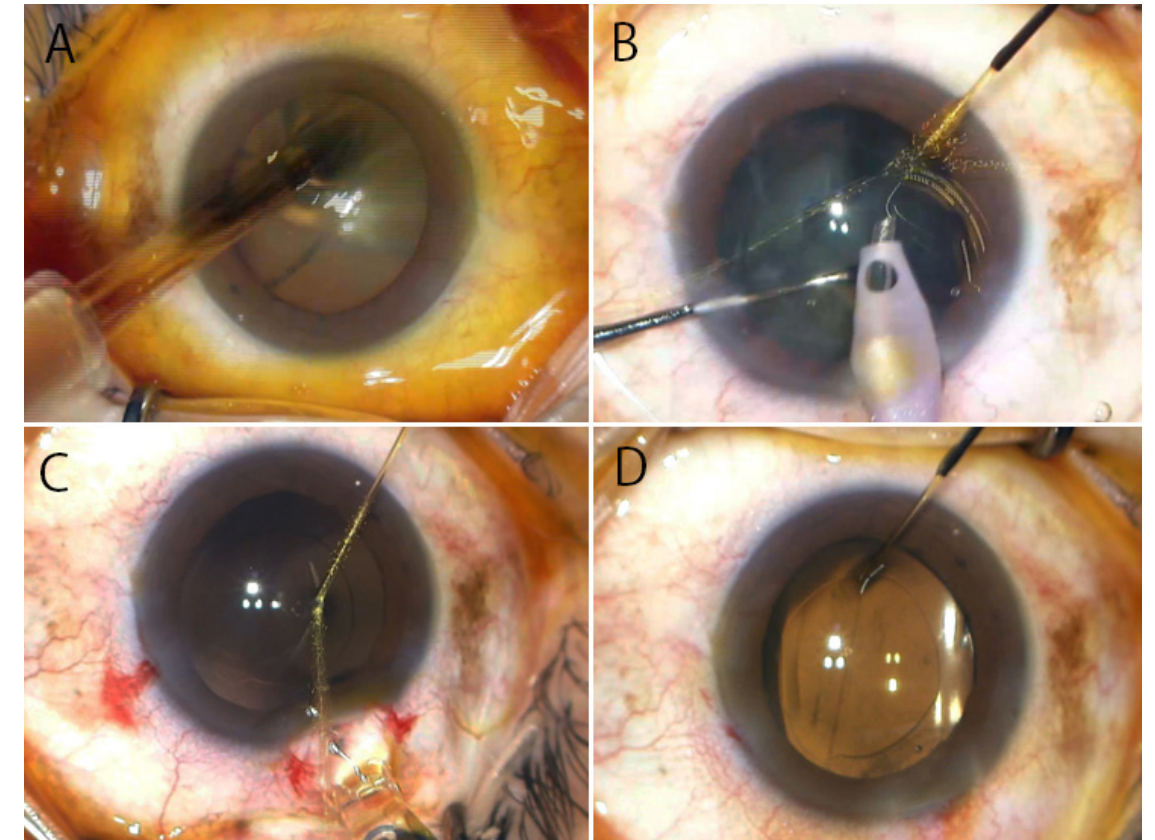
Figure 10. Irrigation of ocular surface with 0.25% povidone-iodine during cataract surgery instead of washing with saline (The Shimada technique). ( A ) Irrigate the ocular surface with 0.25% povidone-iodine after placing the speculum. ( B ) While irrigating the cornea, make sure that 0.25% povidone-iodine accumulates in the conjunctival sac. ( C ) Since 0.25% povidone- iodine shows a bactericidal effect within 15 s, irrigate every 20–30 s during surgery; especially, irrigate before inserting the intraocular lens. ( D ) Irrigate also at the end of surgery. The applied 0.25% povidone-iodine flows from the cornea to the conjunctiva, so the visibility of the anterior chamber is good. Fresh 0.25% povidone-iodine is applied to the cornea before the corneal surface becomes dry due to flow of 0.25% povidone-iodine to the conjunctiva. (Authors’ unpublished images).